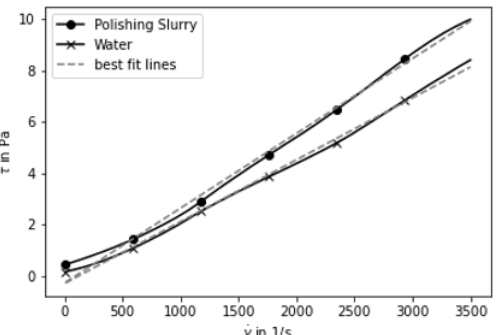
Figure 3: Shows the comparison of the viscosity of water and water with opalines (polishing